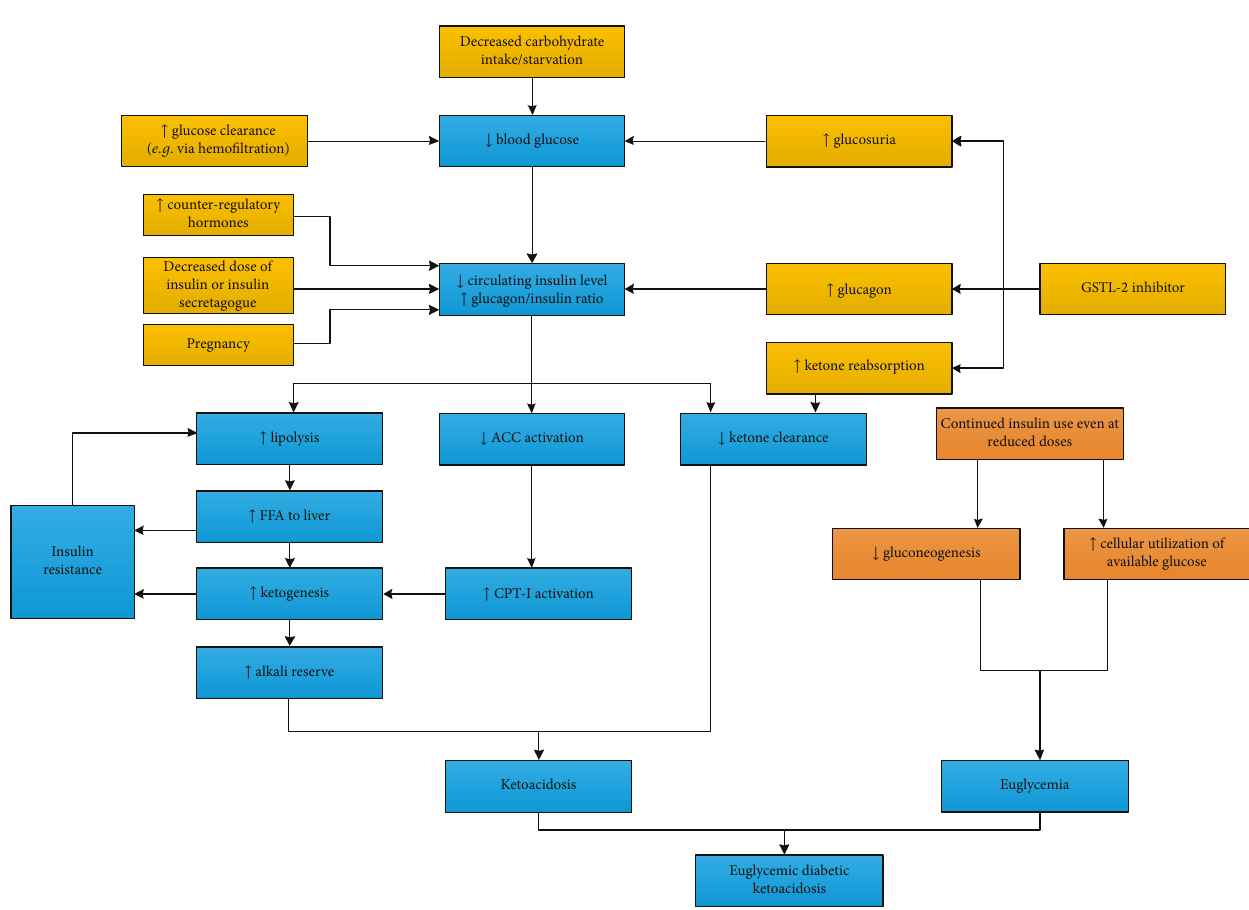
Figure 1: Possible pathogenesis of EDKA. ACC: acetyl coenzyme A carboxylase; CPT-I: carnitine palmitoyltransferase-I; FFA: free fatty